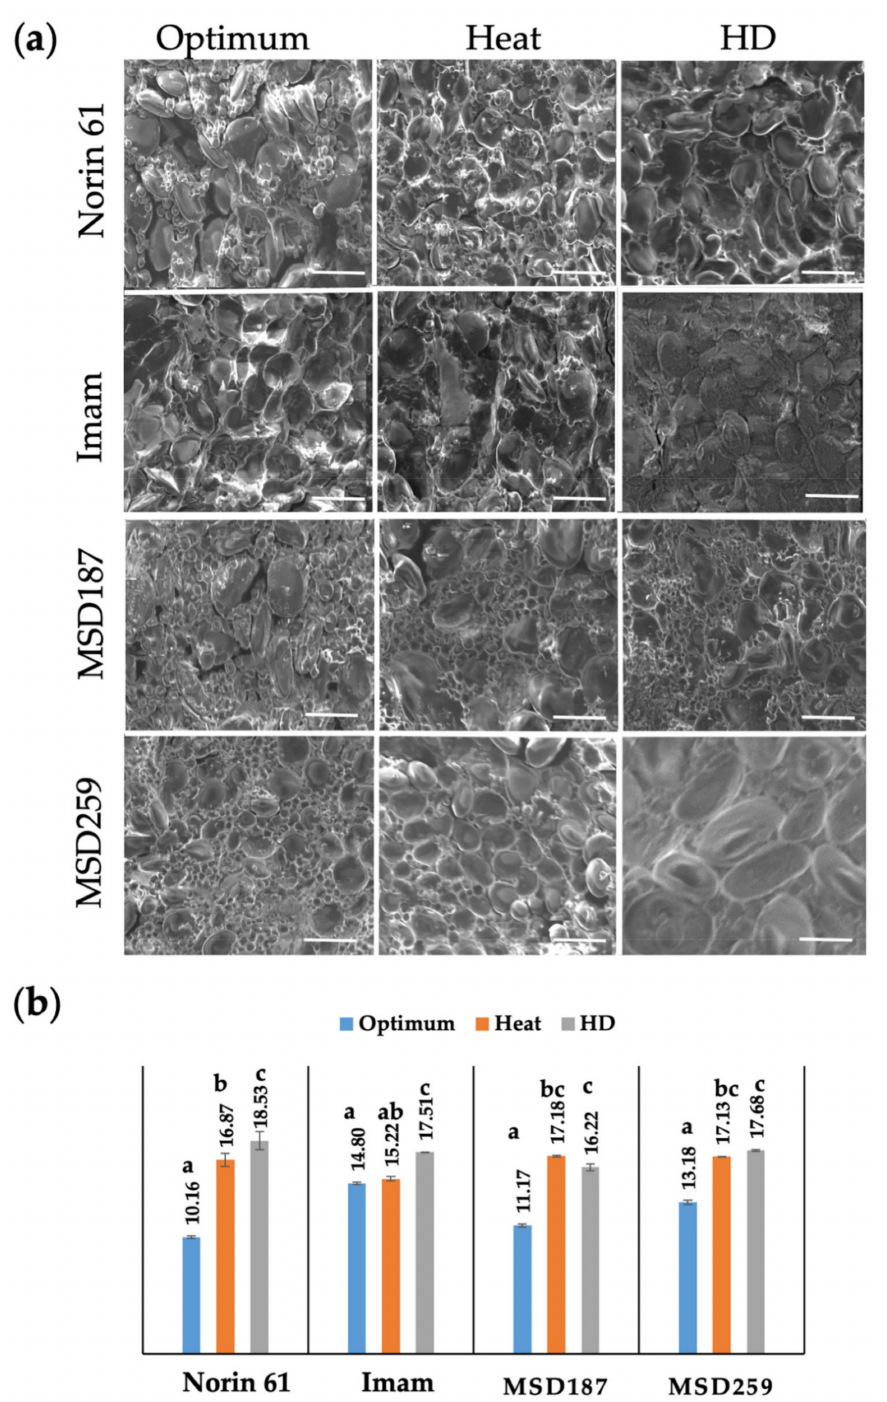
Figure 4. Scanning electron microscope showing the internal structure of wheat endosperm for Imam, Norin 61,